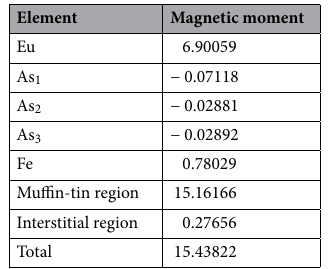
Table 3. Calculated magnetic moments (in µ B